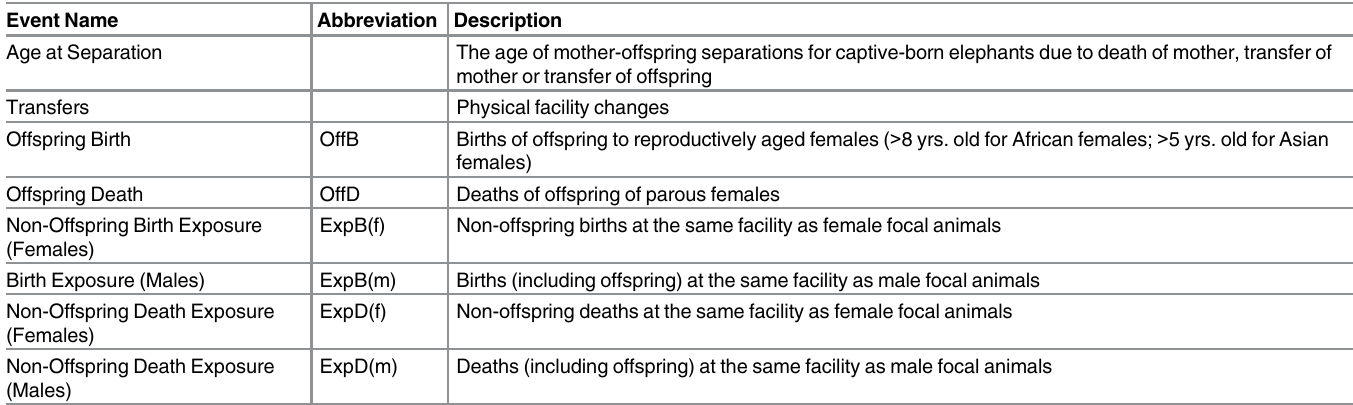
Table 2. Description of social life events recorded in